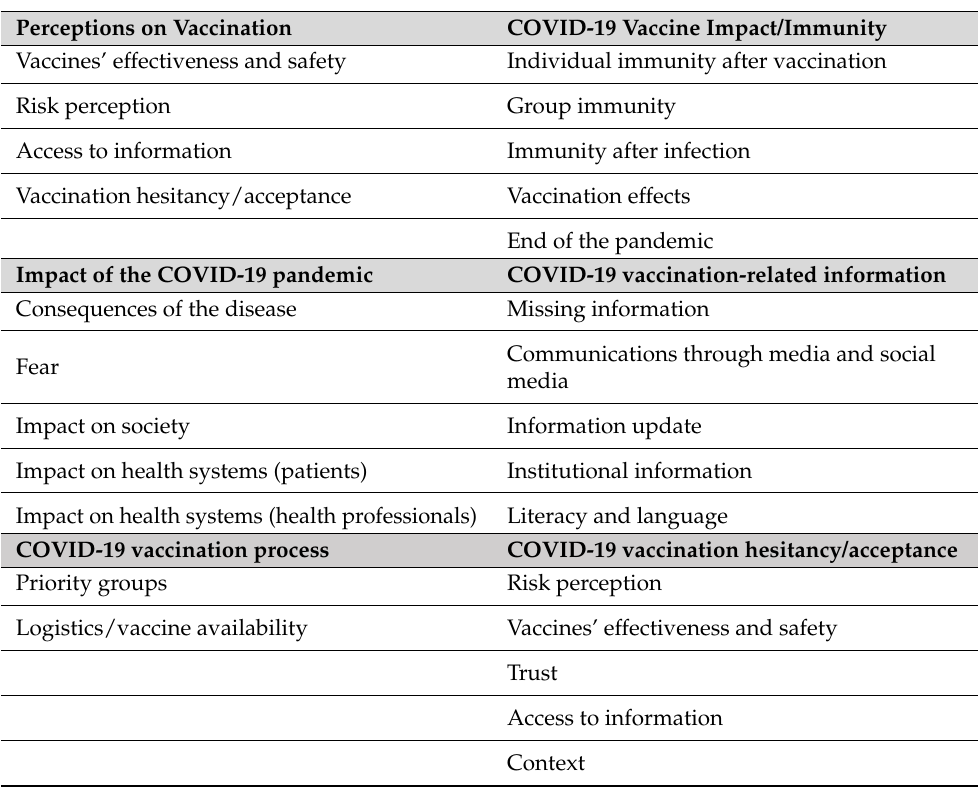
Table 1. Identified themes and subthemes. Perceptions on